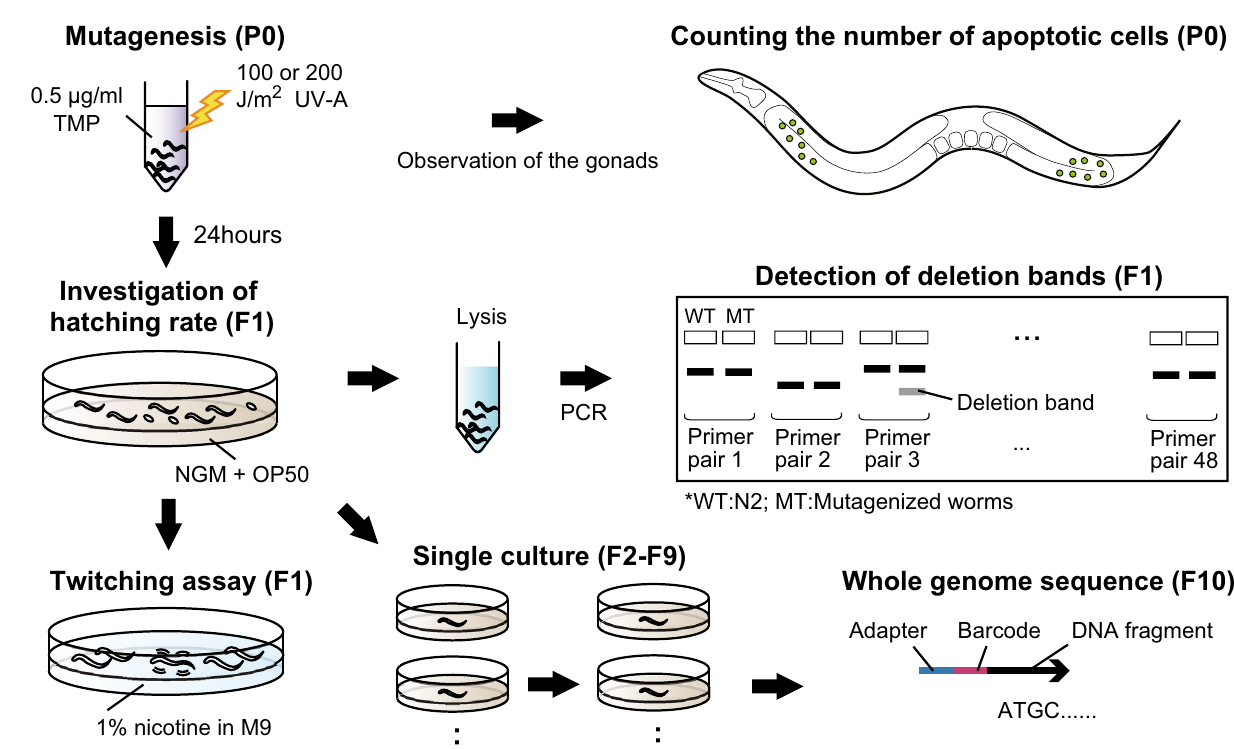
Figure 1. Experimental design. The adult worms were exposed to TMP and irradiated with UV. Apoptotic cells in the gonads were counted 2 h after and obtained F1 eggs by washing off the adults and larvae 24 h after the mutagenesis. The hatching rates were measured the next day. The thousands of the siblings of hatched F1 larvae were soaked with 1% nicotine for the twitching assay and other thousands of F1 worms were lysed to detect deletions by PCR. For the whole genome sequencing, more than 5 F1 worms were randomly picked and cultured individually. The single culturing was repeated until the F9 generation and the starved F10 worms were used to extract genomic DNA. The extracted genome was sheared and about 120 base fragments were tagged by the adapter and barcode sequence. Finally, the mixture of the tagged DNA was sequenced using ionProton system.